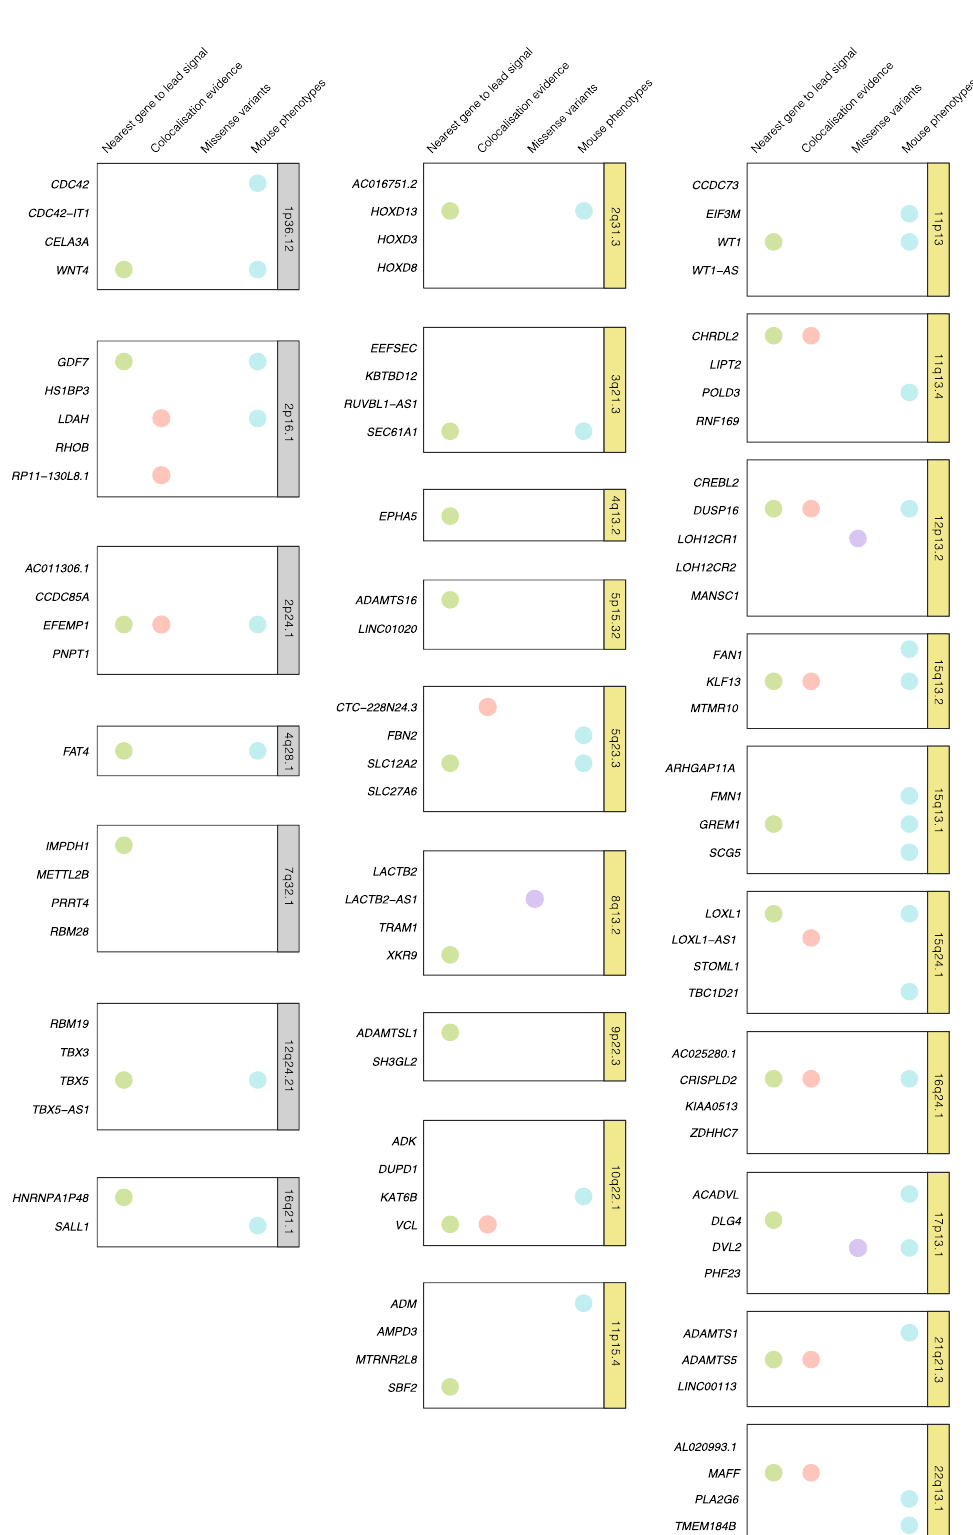
Fig. 2 Evidence for pelvic organ prolapse GWAS meta-analysis candidate gene mapping. Previous reported loci are highlighted in gray frames and previously unidenti fi ed loci in yellow frames. We prioritized candidate genes considering at least the presence of one of the next four main evidence levels: (1) nearest gene to the association peak (indicated by green dots); (2) genes containing shared causal variants between genetic variants and gene expression signatures unraveled by colocalization analyses (shown as orange dots); (3) genes containing coding variants or in high LD (r2 > 0.6) with these (shown as purple dots); and (4) genes which showed embryo, growth/size/body, muscle, renal/urinary system, reproductive system, digestive/alimentary system phenotypes in mutant